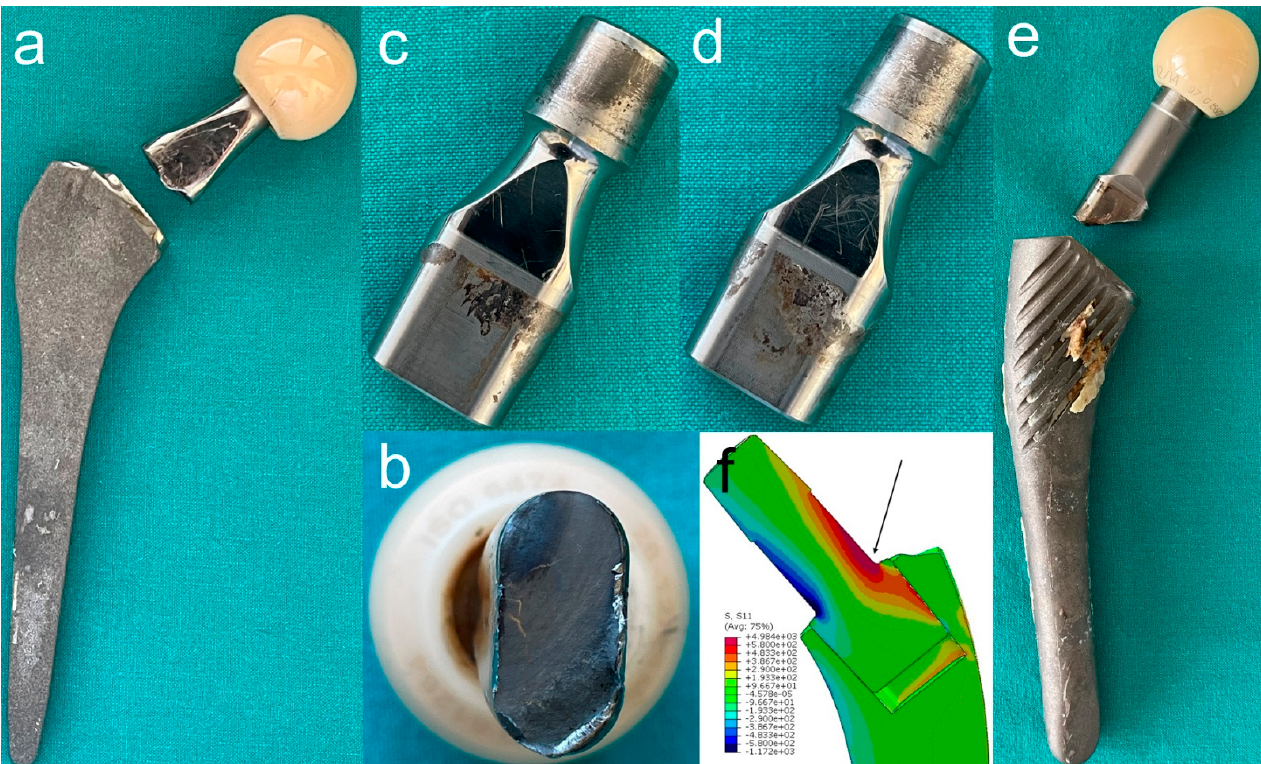
Figure 3. Consequences of corrosion at the interchangeable neck-femoral stem junction. ( a , b ) A photograph of a fractured long straight modular neck 15.5 years after implantation of a dual modular femoral stem (Profemur Z, Wright Medical Technology Inc.). Beach marks on the fractured surface are typical for a Ti6Al4V alloy. ( c , d ) Both sides of an explanted short straight modular neck 14 years after primary THA. Revision was done due to aseptic loosening of the acetabular component. Note corrosion signs at the oval distal taper. ( e ) A photograph showing a fractured long straight modular neck 20.3 years after implantation of a dual-modular femoral stem (GSP, Cremascoli S.p.A.) The distal part of the neck remained engaged in the stem. ( f ) A 3D model representation of finite element analysis of bending moments acting on the neck-stem junction in an overweight patient with the femoral configuration shown in ( e ) during stumbling, i.e., where peak forces that are eight times the body weight apply. The arrow is showing the site where cracks in the interchangeable necks are usually